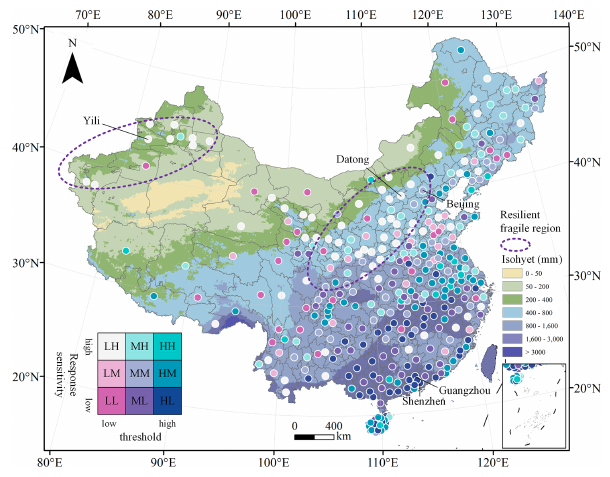
Figure 7. Spatial distribution of urban resilience. The basemap colours indicate the 2017 annual rainfall.